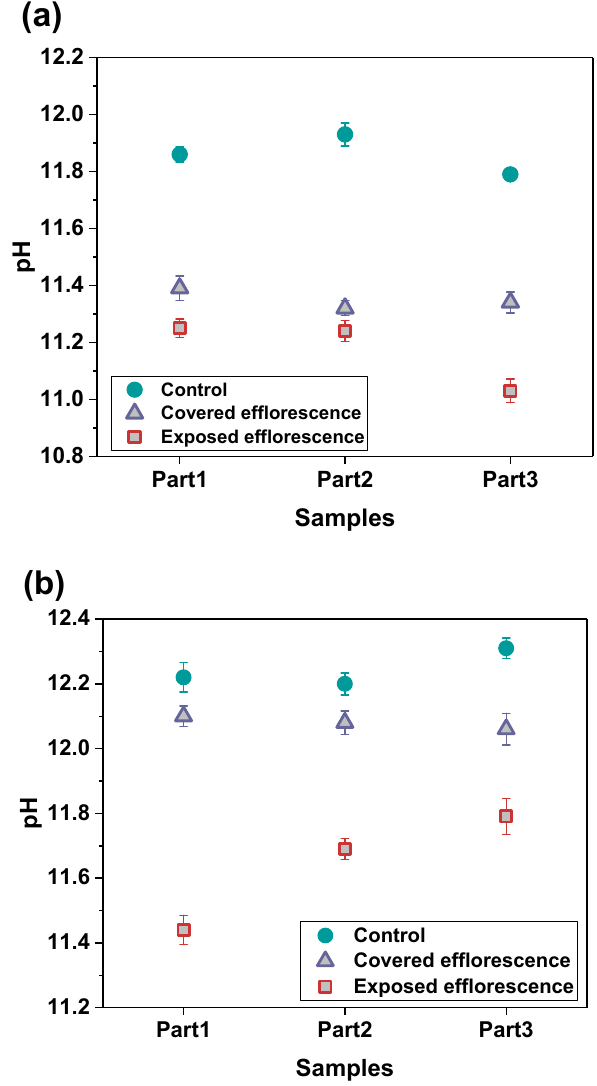
Figure 6. pH values of the leachates of ( a ) NHFS and ( b ) NSFS samples.